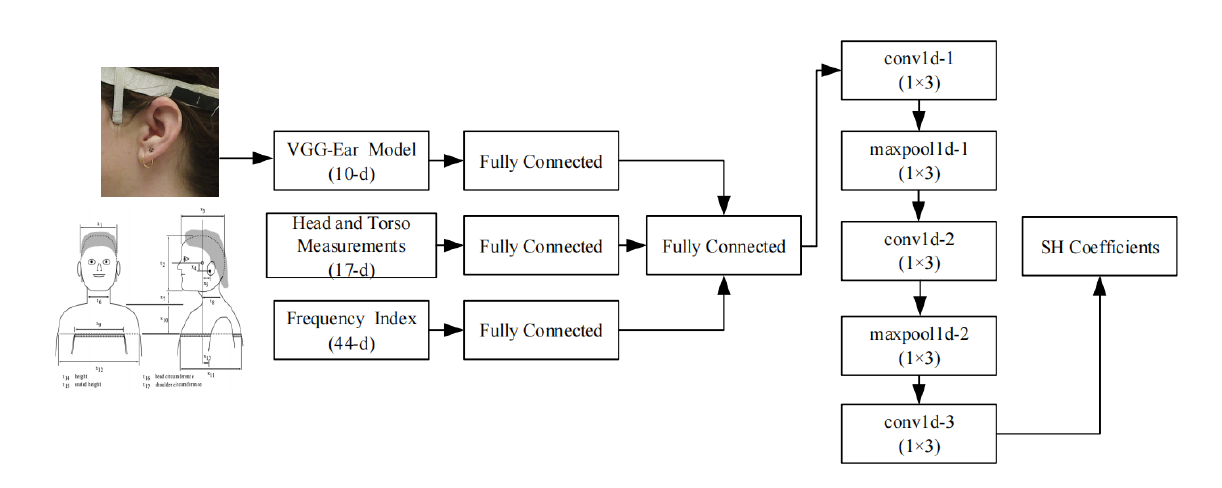
Figure 6. Block diagramof a deep learning network for predicting SH